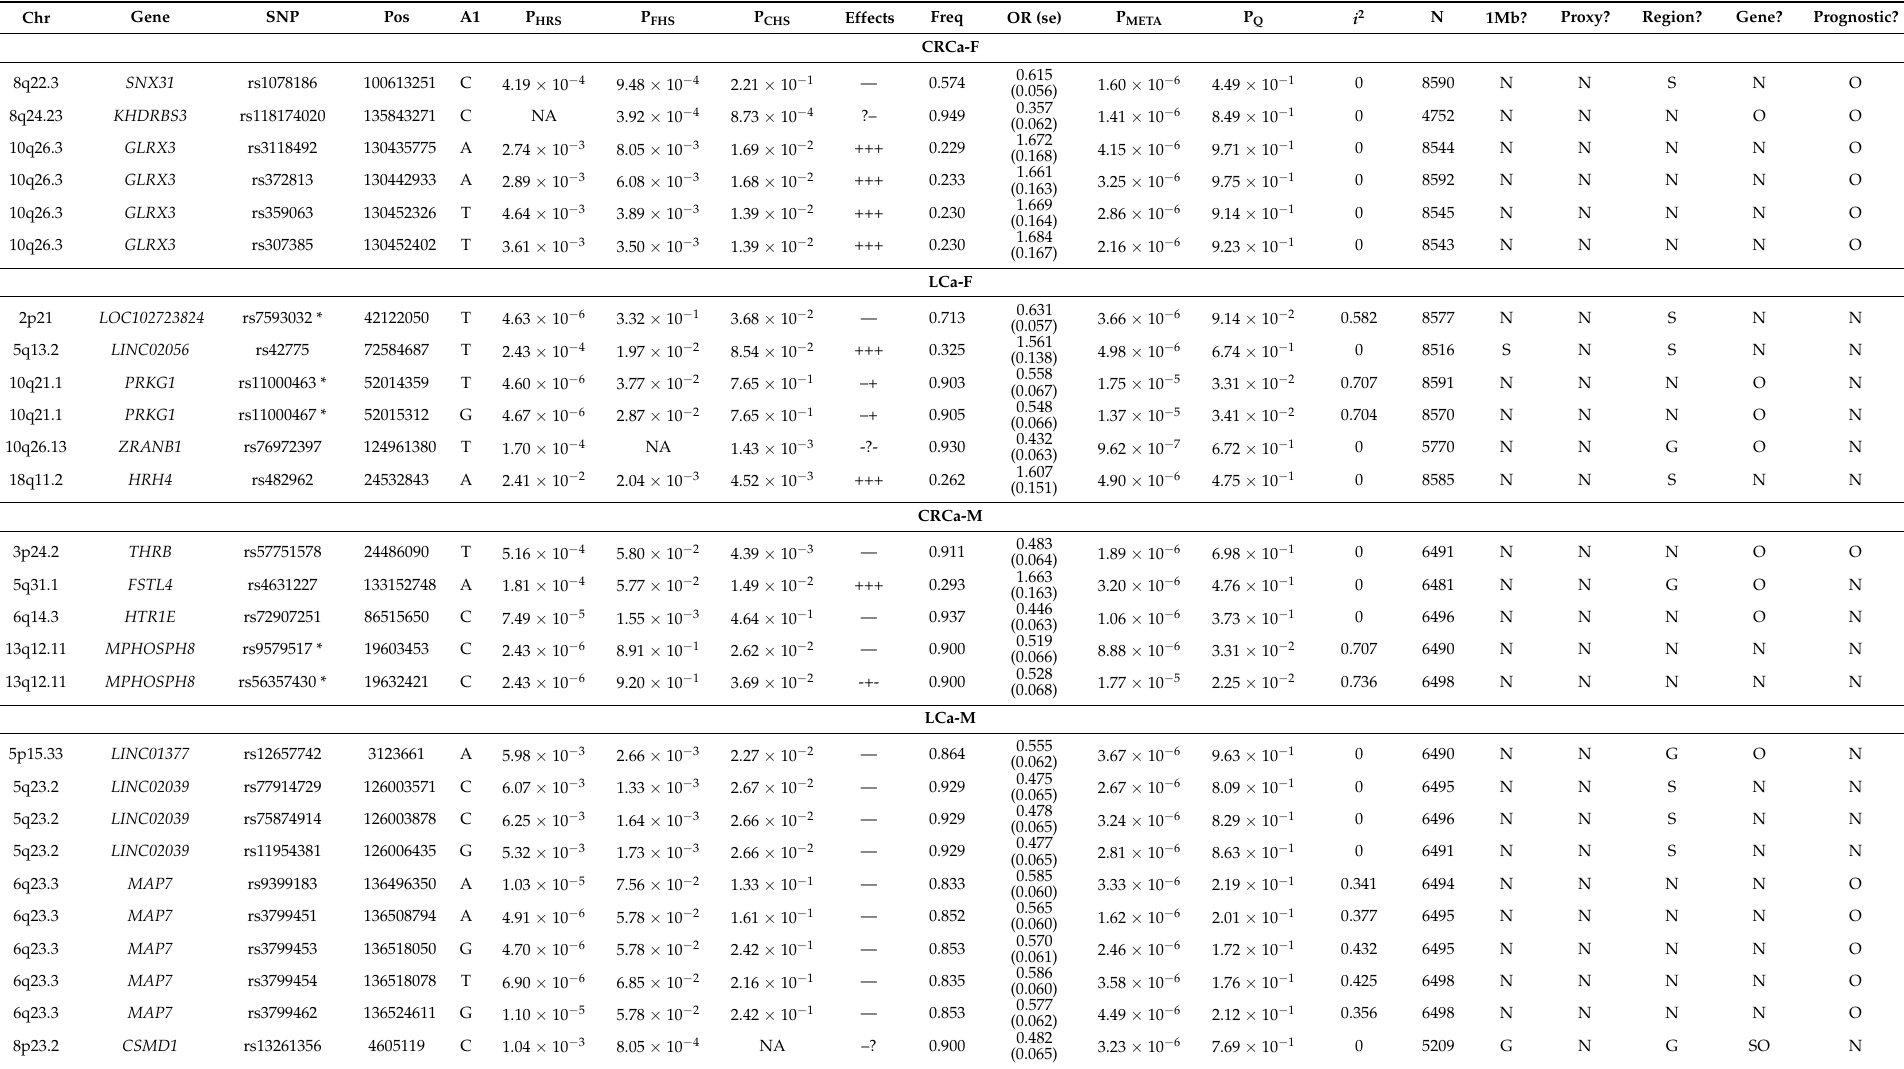
Table 1. Significant findings from genome-wide association